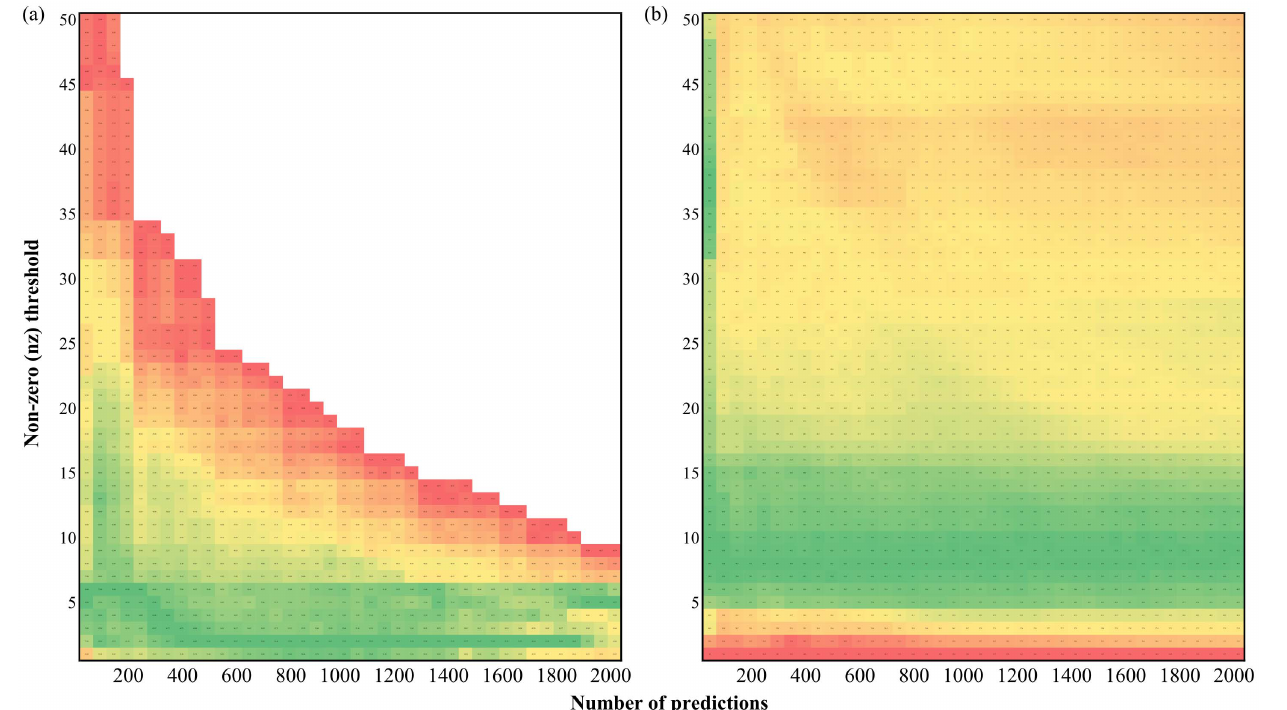
Figure 6.The relationships among the number of predictions ( x -axis), the non-zero thresholds ( y -axis) and the prediction performance (color) with different reference collections of (a) 829 prokaryotes and (b) 132 eukaryotes. Since different applications might require different number of predictions, the colors of a specific abscissa were normalized from red to green. Thus, one can quickly identify the best non-zero threshold under a specific number of predictions.